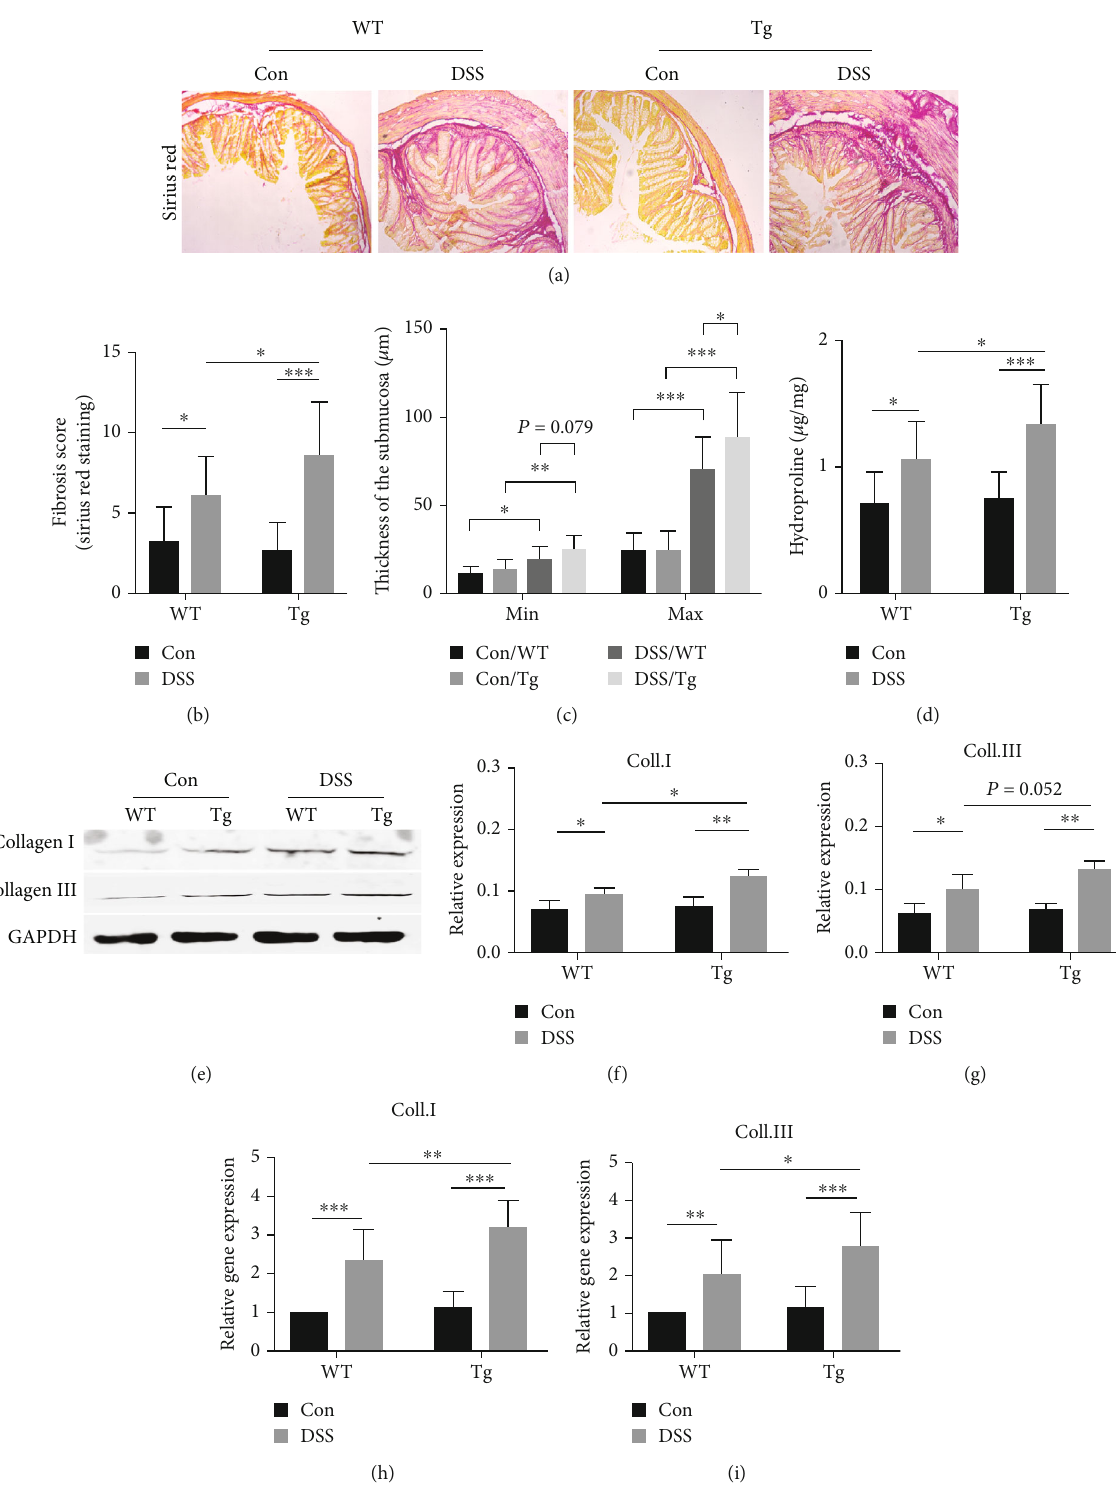
Figure 3: TL1A promotes colon fi brosis in the DSS-induced intestinal fi brosis model. (a) Sirius red staining of collagen deposition in colon from wild type and transgenic (Tg) mice overexpressing TL1A (100x). (b) Fibrosis scores re fl ect fi brotic alterations of colonic sections. (c) The relative minimal (min) and maximal (max) width of submucosa in mice. (d) Hydroxyproline content. (e – g) Western blot analysis of collagen I and collagen III in colonic tissues normalized with GAPDH. (h, i) RT-PCR detection of collagen I and collagen III mRNA. Data were given as mean ± standard deviation (SD). As compared to the control group: ∗ P < 0 : 05 , ∗∗ P ≤ 0 : 01 , and ∗∗∗ P ≤ 0 : 001